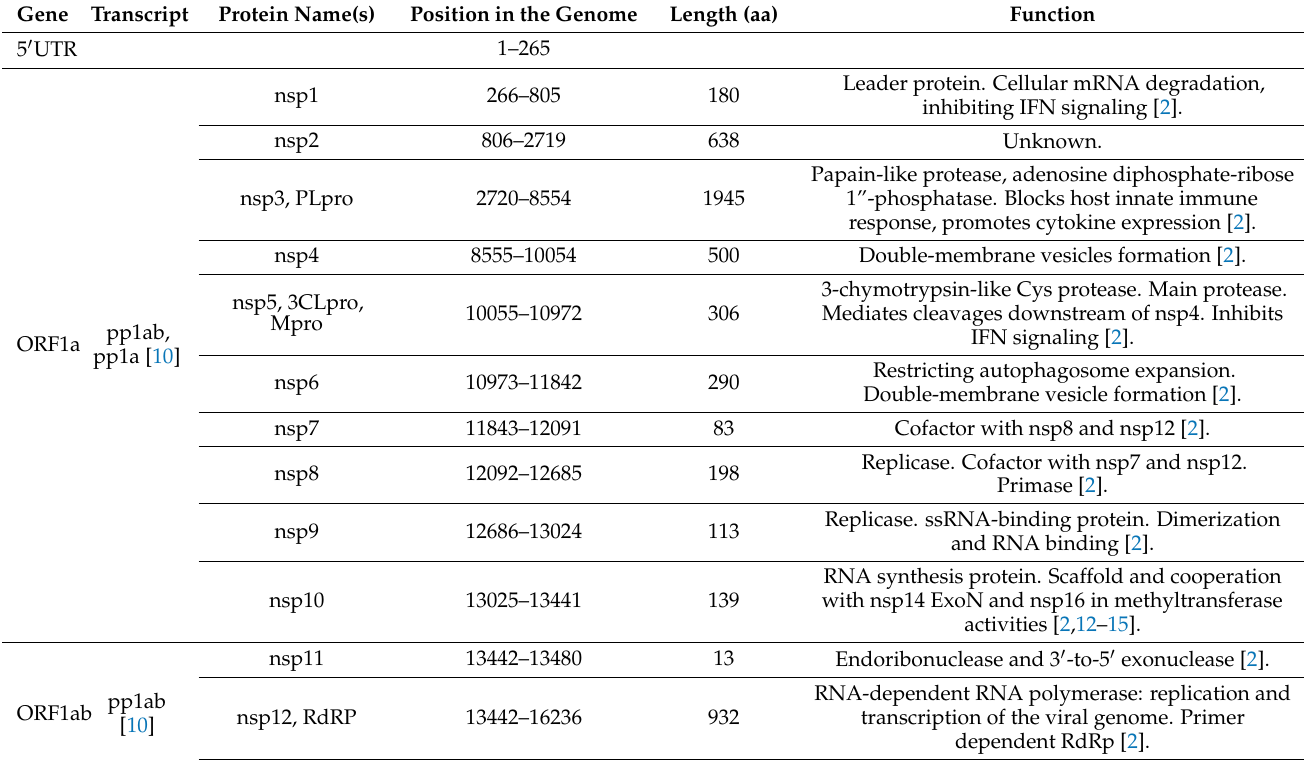
Table 1. SARS-CoV-2 genome structure. Polyproteins pp1a and pp1ab synthesize non-structural proteins nsp1–nsp16, which are responsible for the replication of ssRNA. The 3 (cid:48) third of the genome contains genes that synthesize structural proteins and ORFs. Many of the resulting proteins still have unknown functions. Data were collected from NCBI’s public gene database (https://www.ncbi.nlm.nih.gov/gene accessed on 14 September 2021) and [2,10–20]. Adapted from [2]. Gene